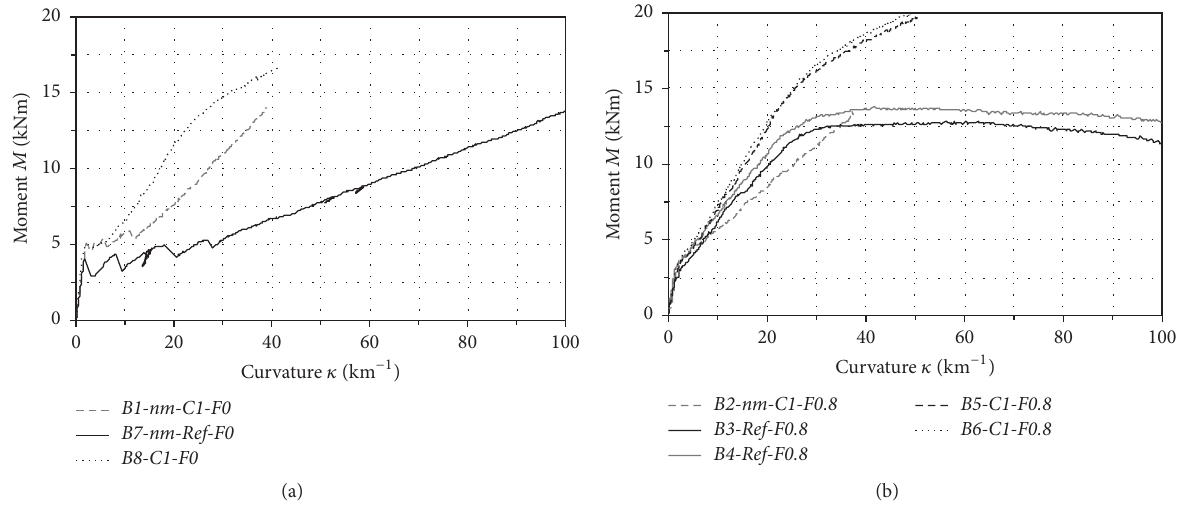
Figure 9: Moment-curvature diagrams of the beams made of ordinary concrete (a) and SFRC (b).